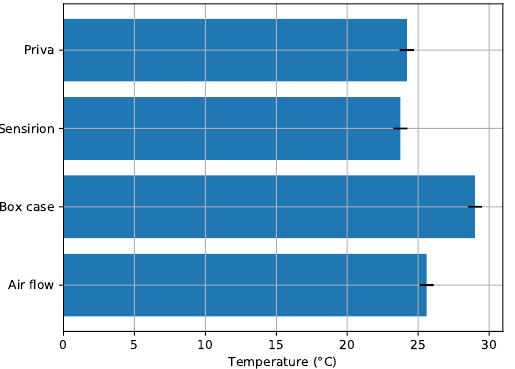
Figure 5. Temperature readings from different